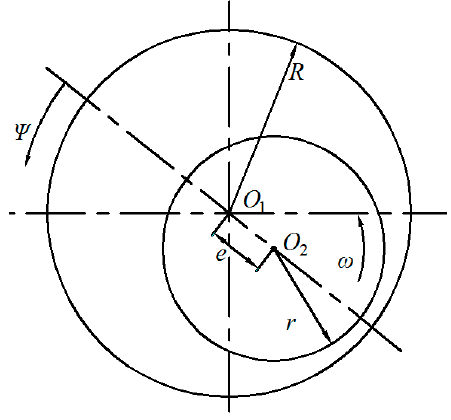
Figure 1. Schematic of the journal bearing.